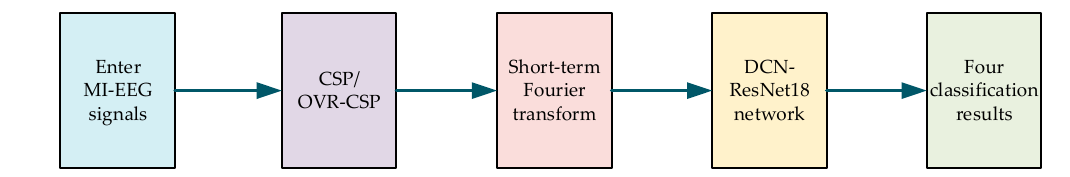
Figure 7. Identification block diagram.